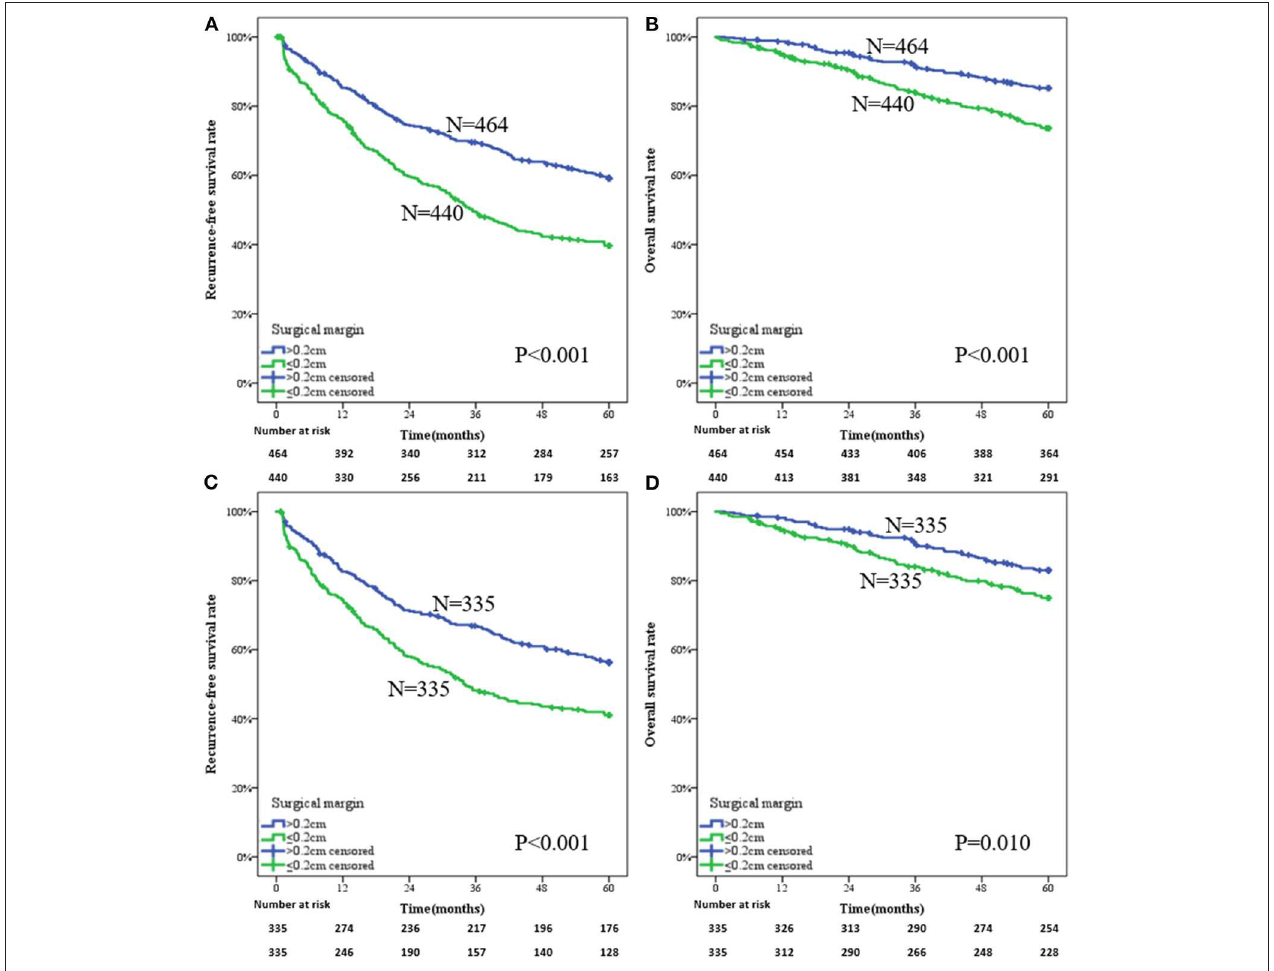
FIGURE 2 | Survival analysis of a wide-margin vs. a narrow-margin liver resection for the early solitary hepatocellular carcinoma. (A) Recurrence-free survival in the whole patients, (B) overall survival in the whole patients, (C) recurrence-free survival in the patients after propensity score matching, (D) overall survival in the patients after propensity score